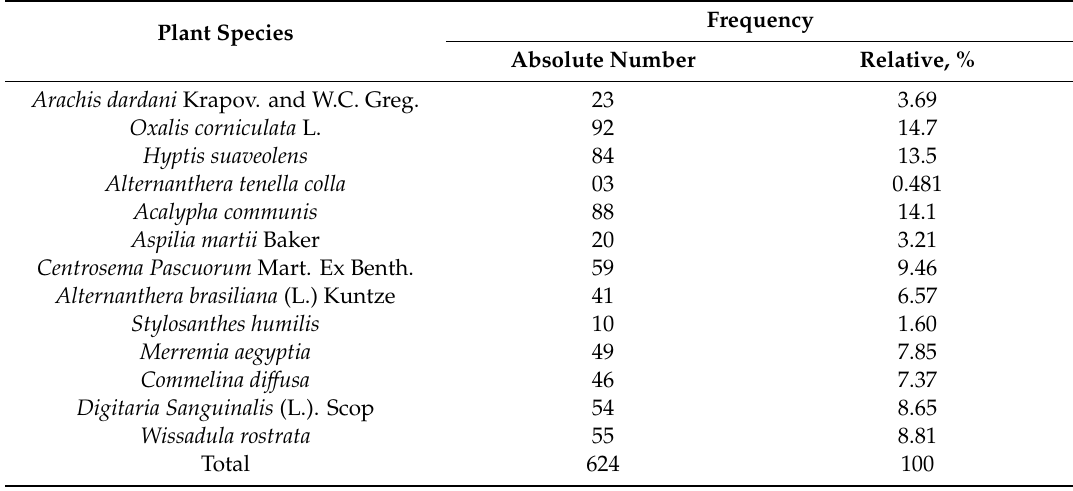
Table 2. Frequency of main herbaceous species in Caatinga -native pasture during the rainy season. Frequency Plant Species Absolute Number Relative, %